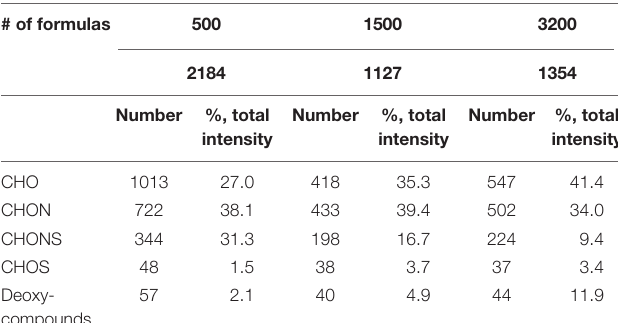
TABLE 1 | Elemental grouping of assignable peaks at different